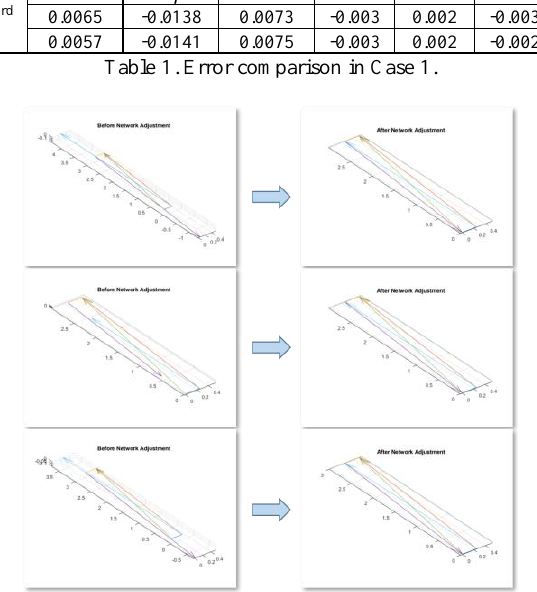
Figure 10. The differences of ROPs before and after applying network adjustment in Case 1.